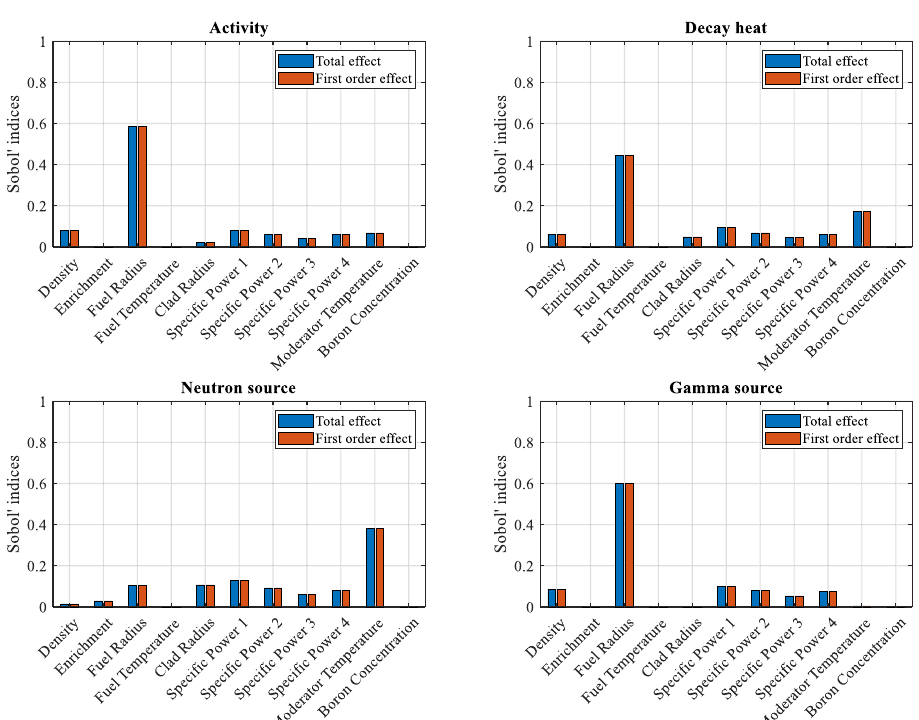
Figure 5. Sobol’ indices (total and first order effects) for the 11 uncertain input parameters.